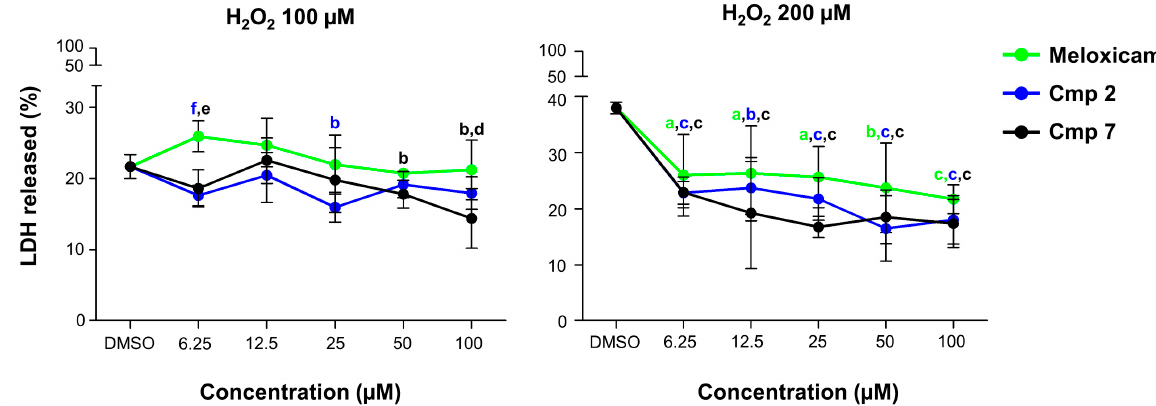
Figure 3. Lactate dehydrogenase (LDH) released from tendon-derived cells pre-incubated with hydrogen peroxide (H 2 O 2 ) in the presence of Meloxicam and Cmp 2 and Cmp 7 . Data are reported as means ± standard deviations of independent experiments with the three donors pooled (n = 9). Trend lines show the percentage of LDH released from tenocytes pre-incubated with H 2 O 2 100 and 200 µ M for 3 h and afterwards exposed to loading concentrations of Meloxicam, Cmp 2 , and Cmp 7 for 24 h. Values are normalized on 3-(4,5-dimethylthiazol-2-yl)-2,5-diphenyltetrazolium bromide (MTT) data obtained from the same experiment. DMSO = cultures pre-incubated with H 2 O 2 and treated with DMSO 0.2% (vehicle). a = p < 0.01; b = p < 0.001; c = p < 0.0001; between samples and DMSO alone; d = p < 0.01; e = p < 0.001; f = p < 0.0001 between samples and Meloxicam at the same